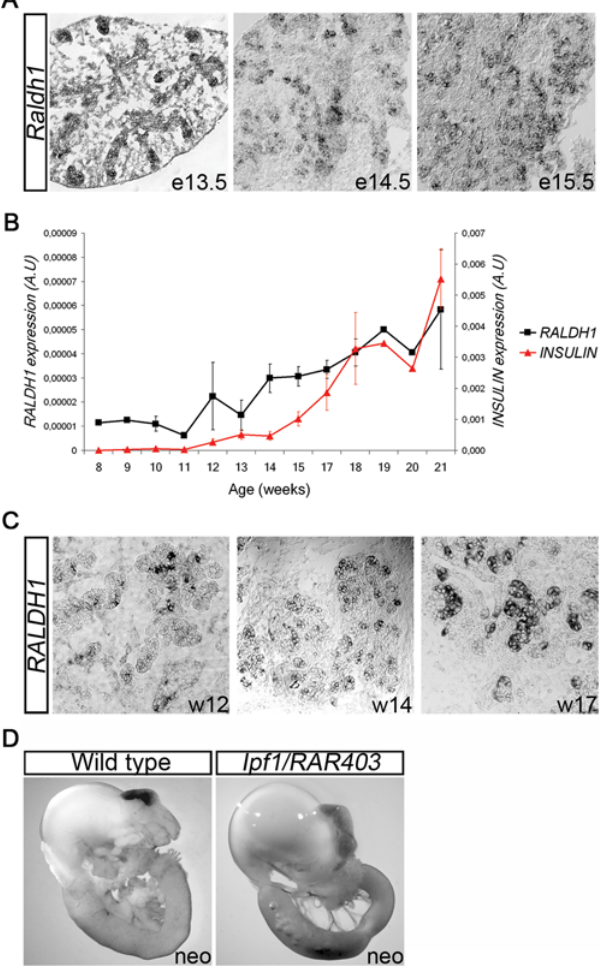
Figure 1. Raldh1 expression in mouse and human embryonic pancreas. ( A ) In situ hybridization of an e13.5, e14.5 and e15.5 mouse pancreas using a Raldh1 probe. ( B ) qRT-PCR using cDNA prepared from human fetal pancreas (n=3 for week 8, 9, 10, 11, 13, 14 and 18, n=2 for week 12, 15, 17 and 21, n=1 for week 19 and 20) with RALDH1 and INSULIN specific primers. ( C ) In situ hybridizations of week 12, week 14 and week 17 human fetal pancreas using a RALDH1 probe. ( D ) The stomach-duodenal region from a wild-type and an Ipf1/RAR403 transgenic neonatal mouse.